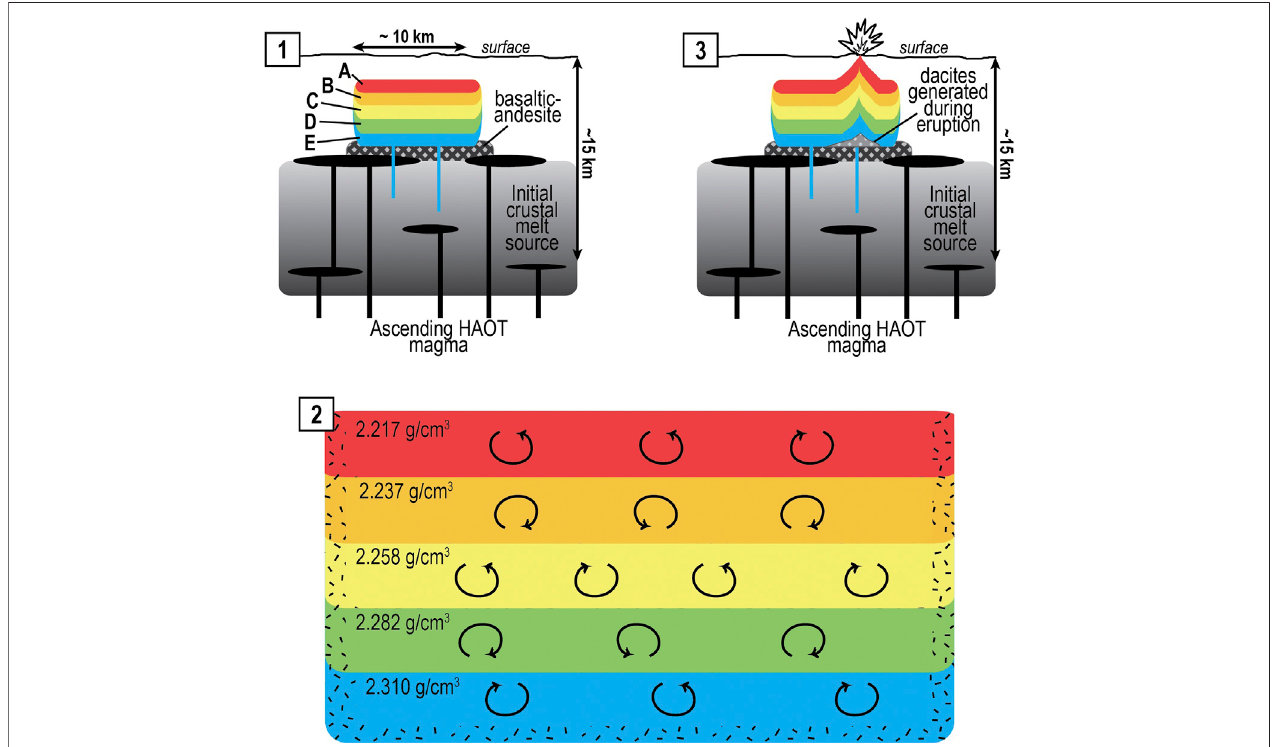
FIGURE 13 | A single, density-strati fi ed, meromictic magma chamber to consider for the Rattlesnake Tuff magma con fi guration, a similar model to the one proposedbyStreckandGrunder(1995;1997;1999;2008).(1)RSTHSRGroupEformsfrompartialmeltingofregionalma fi ccrust.OtherHSRGroupmagmasdevelop through episodes of crystal fractionation, where one more evolved rhyolite develops from the fractionated product of the less evolved rhyolite before it. (2) HSR magma layers convect within layers but remain unmixed between compositional layers due to suf fi cient density differences. (3) These density boundaries are disturbed during eruption, where all HSR Groups erupt together, and dacite magmas are likely generated from mixing of Group E and underplated enriched basaltic andesite. Labeled densities are those calculated using average storage temperatures ( Figure 8 ), decreasing storage pressure 210 – 150 MPa from Group E to Group A, and increasing water content 2 – 4 wt% from Group E to Group